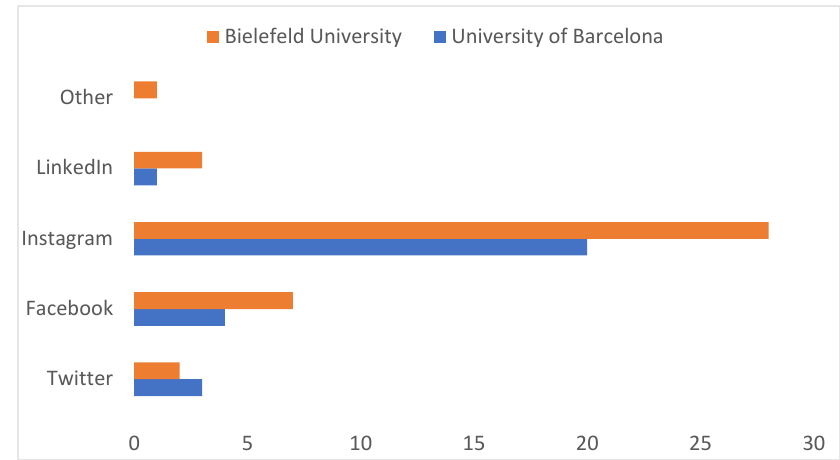
Figure 13. Subscription on the official account of University on social media.